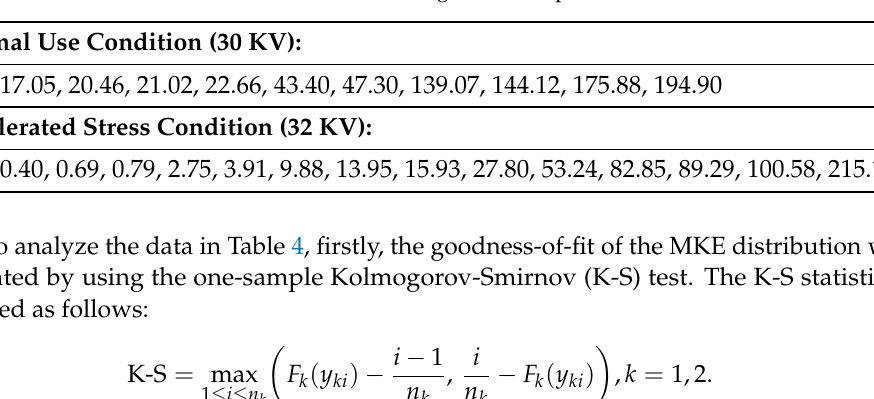
Table 4. Oil breakdown observed times of insulating fluid, complete data.